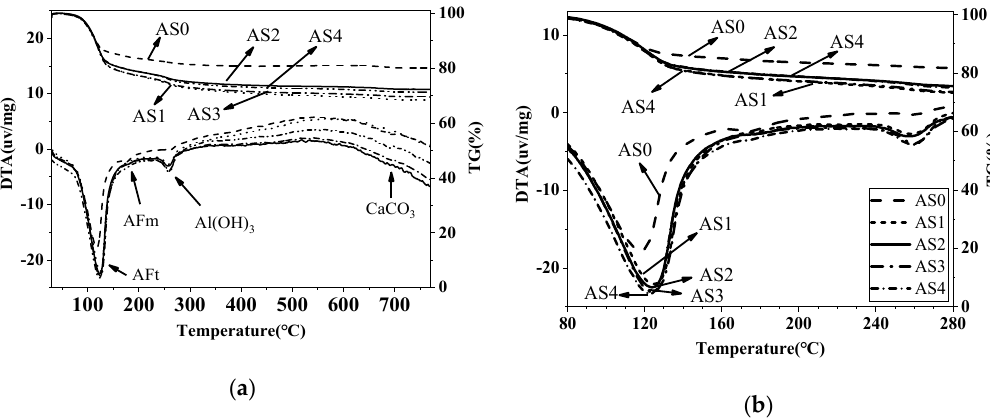
Figure 13. TG-DTA curves of the double liquid grouting materials with different aluminum sulfate content at 1 day: ( a ) Temperature ranges from 40–750 °C; ( b ) Temperature ranges from 80–280 °C.